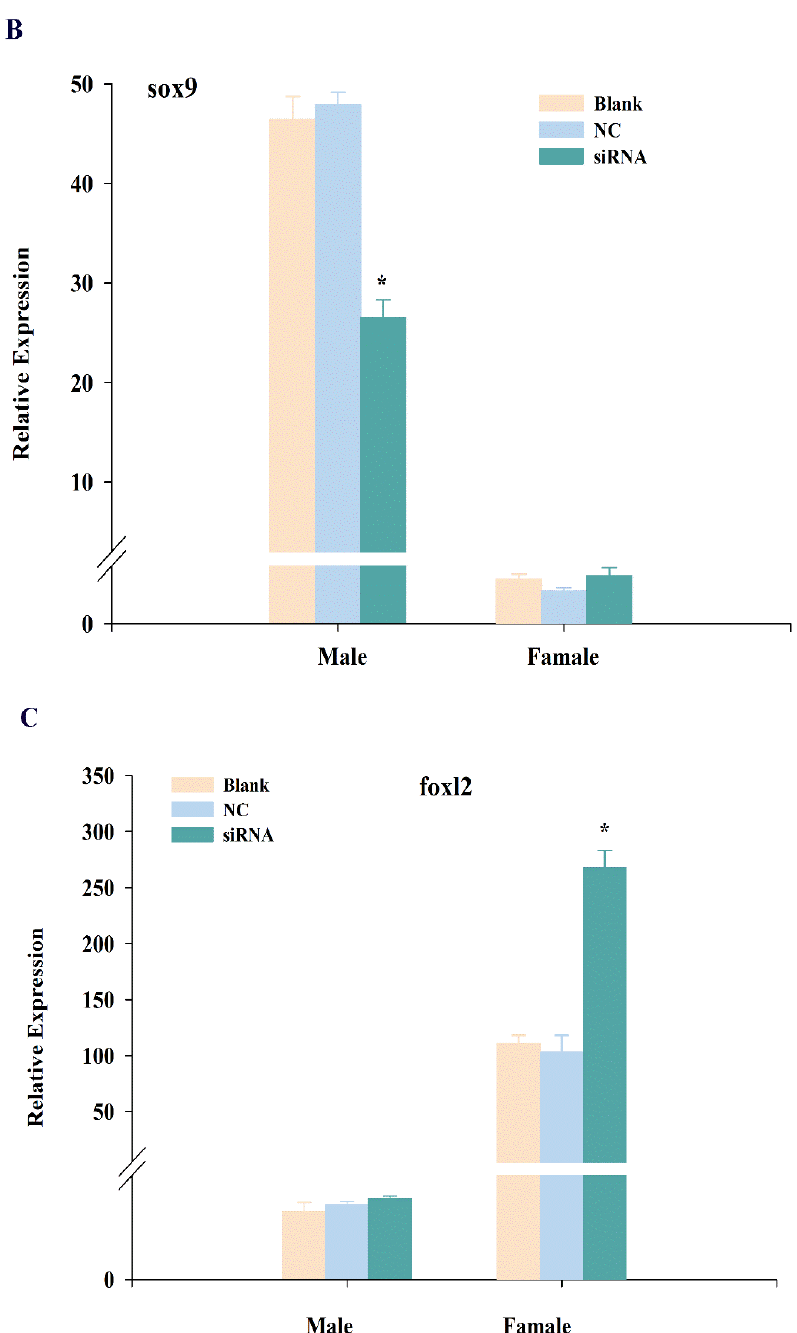
Figure 7. Expression changes of cbx2 ( A ), sox9 ( B ), and foxl2 ( C ) mRNA in gonads after RNA interference. The asterisk represents a statistically significant difference ( P <